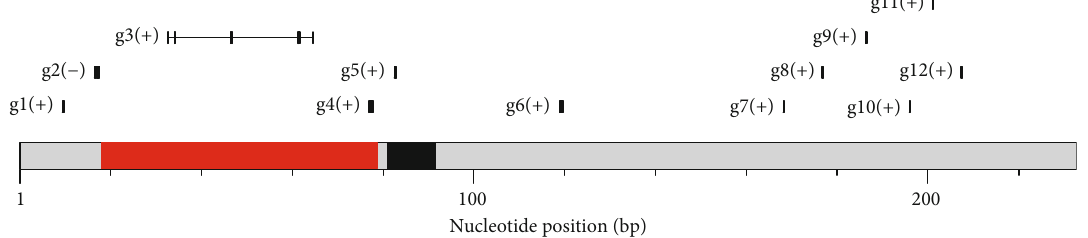
Figure 8: Protein-coding regions in sca ff old M175. The regions predicted with a copy number of 0.5 and 10.7kb SLR and black,